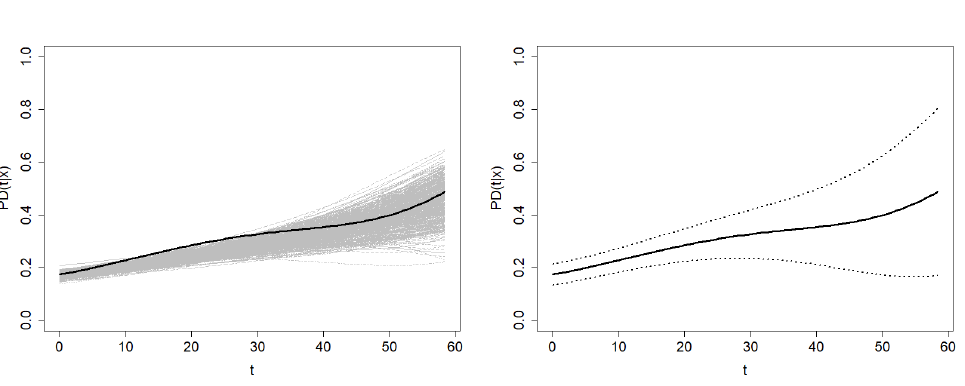
Figure 13. Estimation of PD ( t | x ) with bootstrap bandwidths (black line) along with bootstrap estimations of PD (gray lines) from B = 500 resamples ( left ) and 95% confidence region ( right ) by Beran’s estimator ( top ) and the smoothed Beran’s estimator ( bottom ) when x = 0.85 and t ∈ [ 0,40 ] in the German credit dataset.